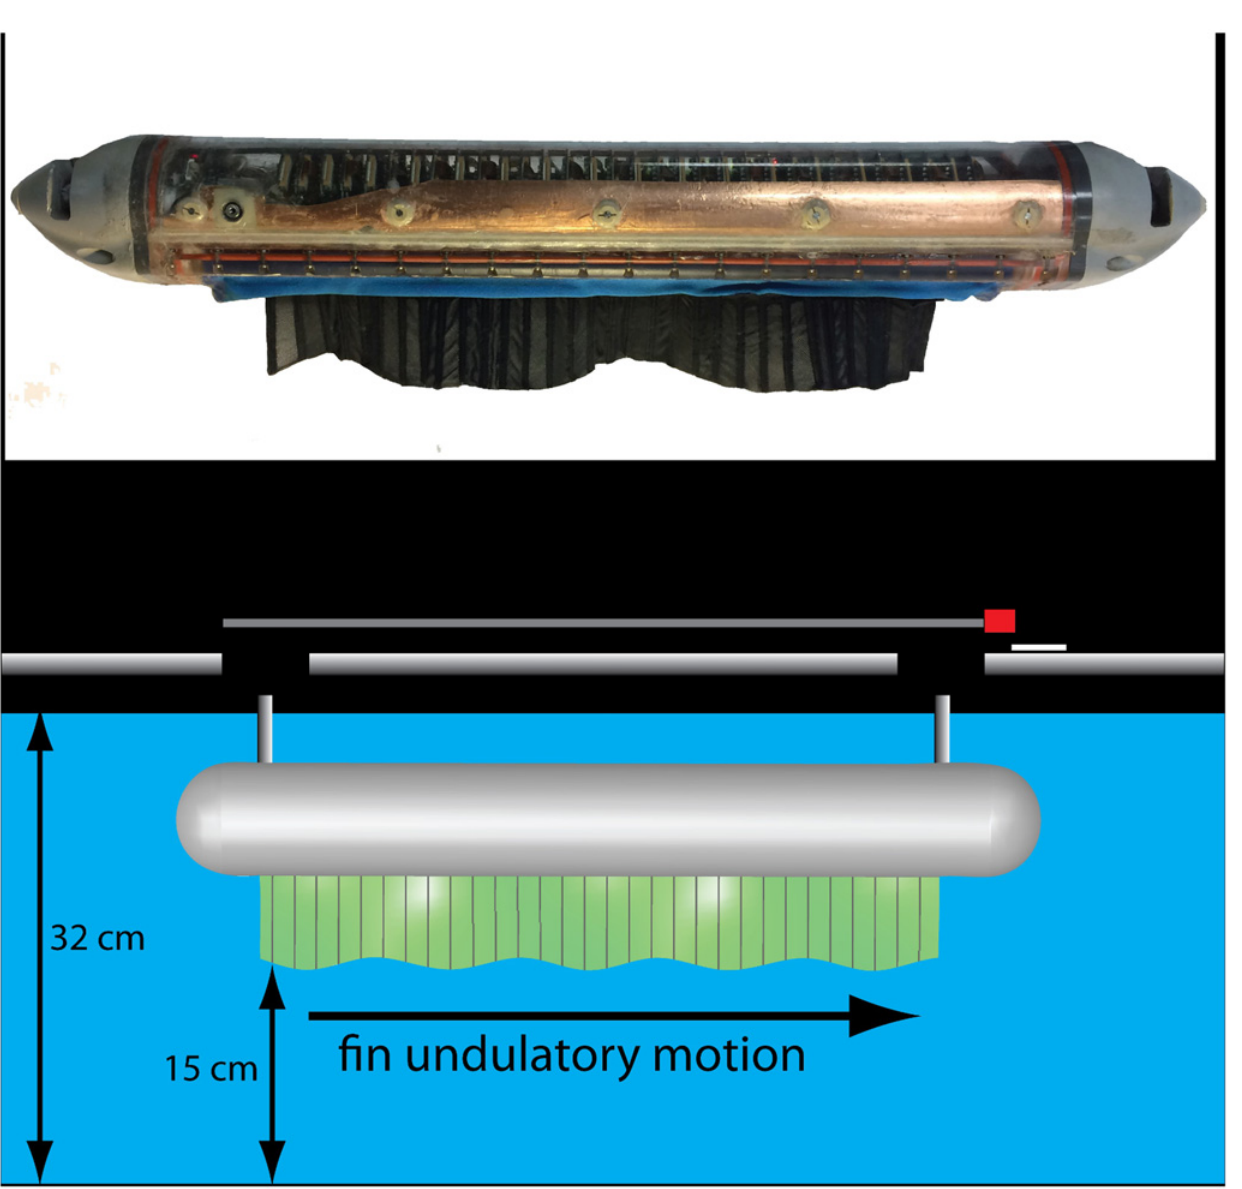
Fig 1. A robot helps understand biology: An underwater robot called Ghostbot was used, along with computer simulations, to test hypotheses concerning convergent evolution of an optimal movement pattern of elongated fins. Image credit: Malcolm MacIver and Izaak